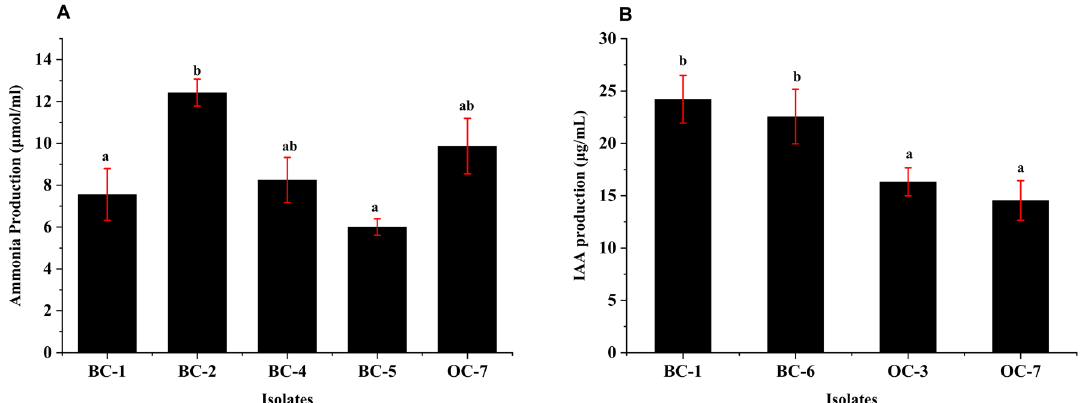
Figure 2. Quantitative estimation of ( A ) Ammonia Production and ( B ) Indole Acetic acid production of the potential Isolates. Results are expressed as means of three replicates and vertical bars shown in the figure represent standard deviations of the means. Significant differences among treatments explained by different alphabetical letters according to T’s-test at p ≤ 0.05.